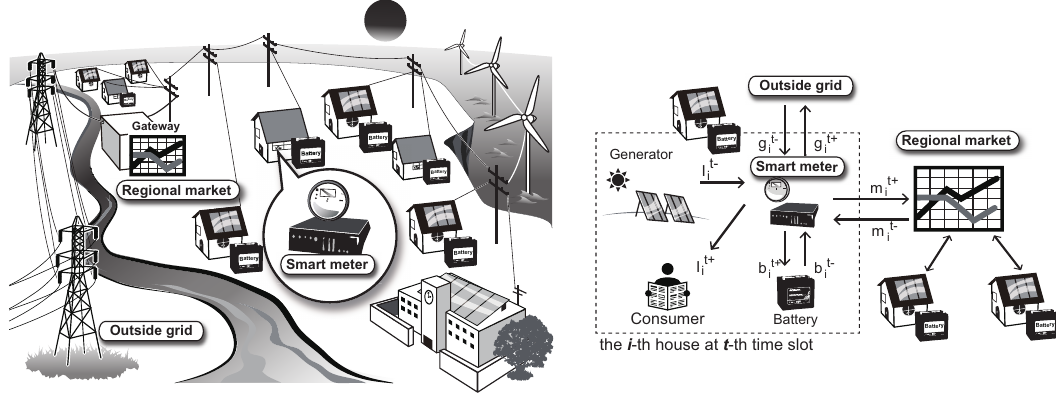
Figure 1. Overview of the inter-intelligent renewable energy network (i-Rene) ( left ) and the power flow and variable definitions in the i-Rene mathematical model ( right )